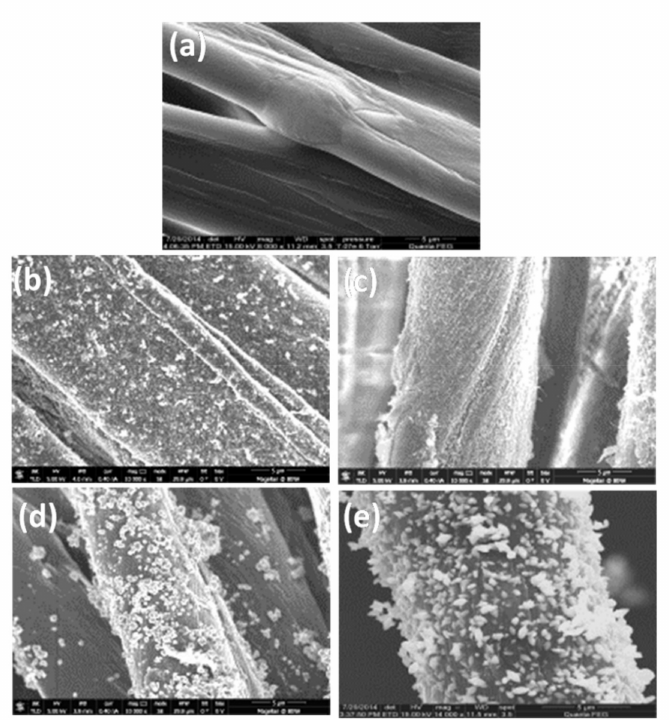
Figure 1. ESEM images of ( a ) pristine cotton, cotton fabric coated with CuO and ZnO NPs in ethanol ( b , d ) or in water ( c , e ); scale bar is 5 µ